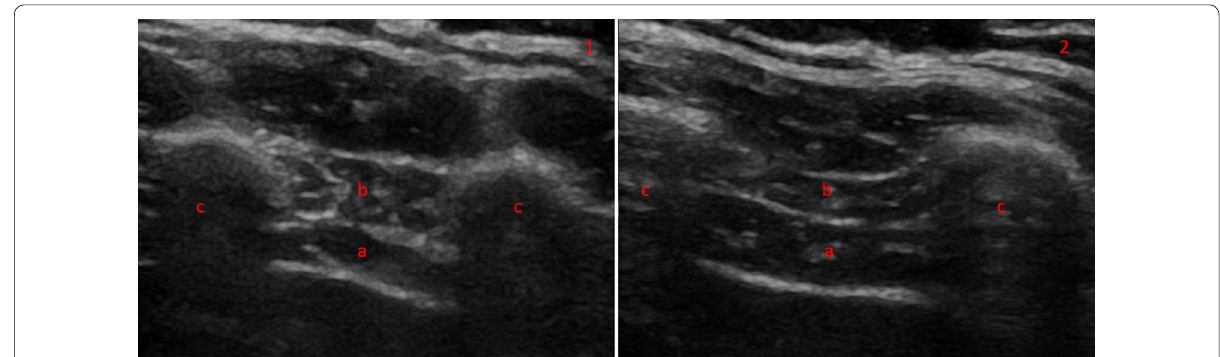
Fig. 4 Diaphragm thickness in B-mode thoracic view at end expiration (1) and inspiration (2) in a heathy volunteer. The diaphragm can be seen between two echogenic layers (a) with the intercostal compartment above (b). The two muscle layers sit between two ribs ( c